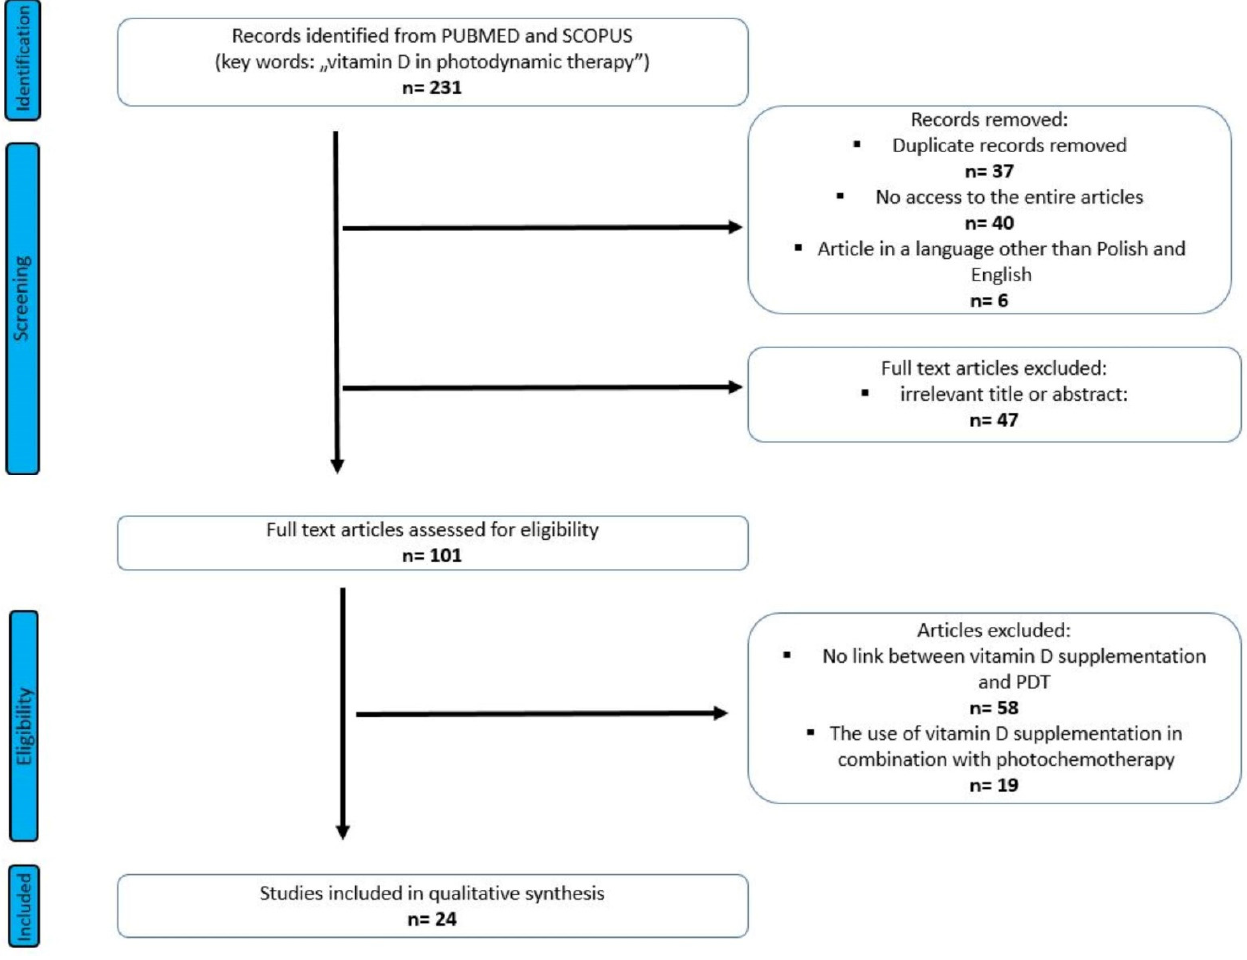
Figure 2. PRISMA flow diagram of included studies.